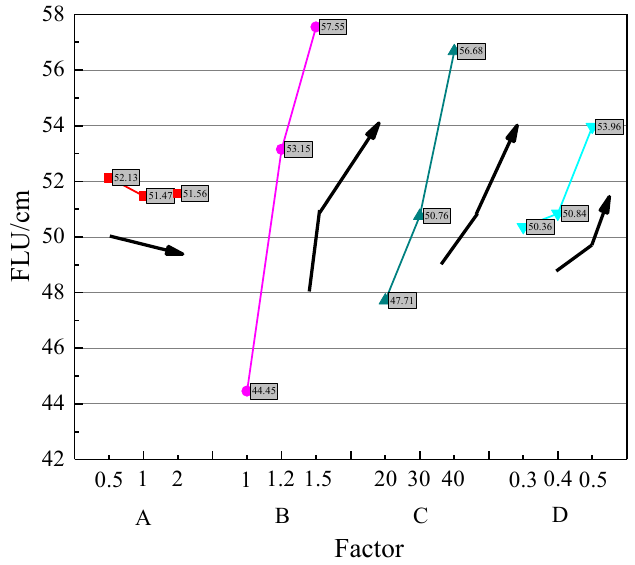
Figure 5. Trend chart of the influence of various factors on FLU. The analysis of Figure 5 and Table 7 indicates that: